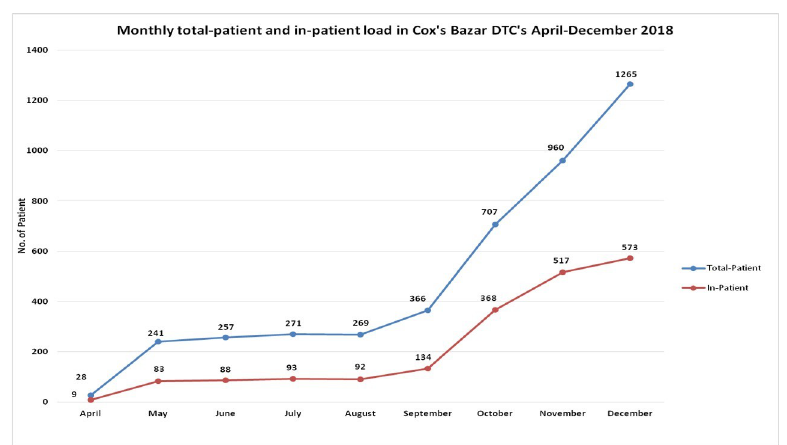
Fig 1. Monthly total-patient and in-patient load in Cox’s Bazar DTCs, April-December 2018, Cox’s Bazar, Bangladesh.